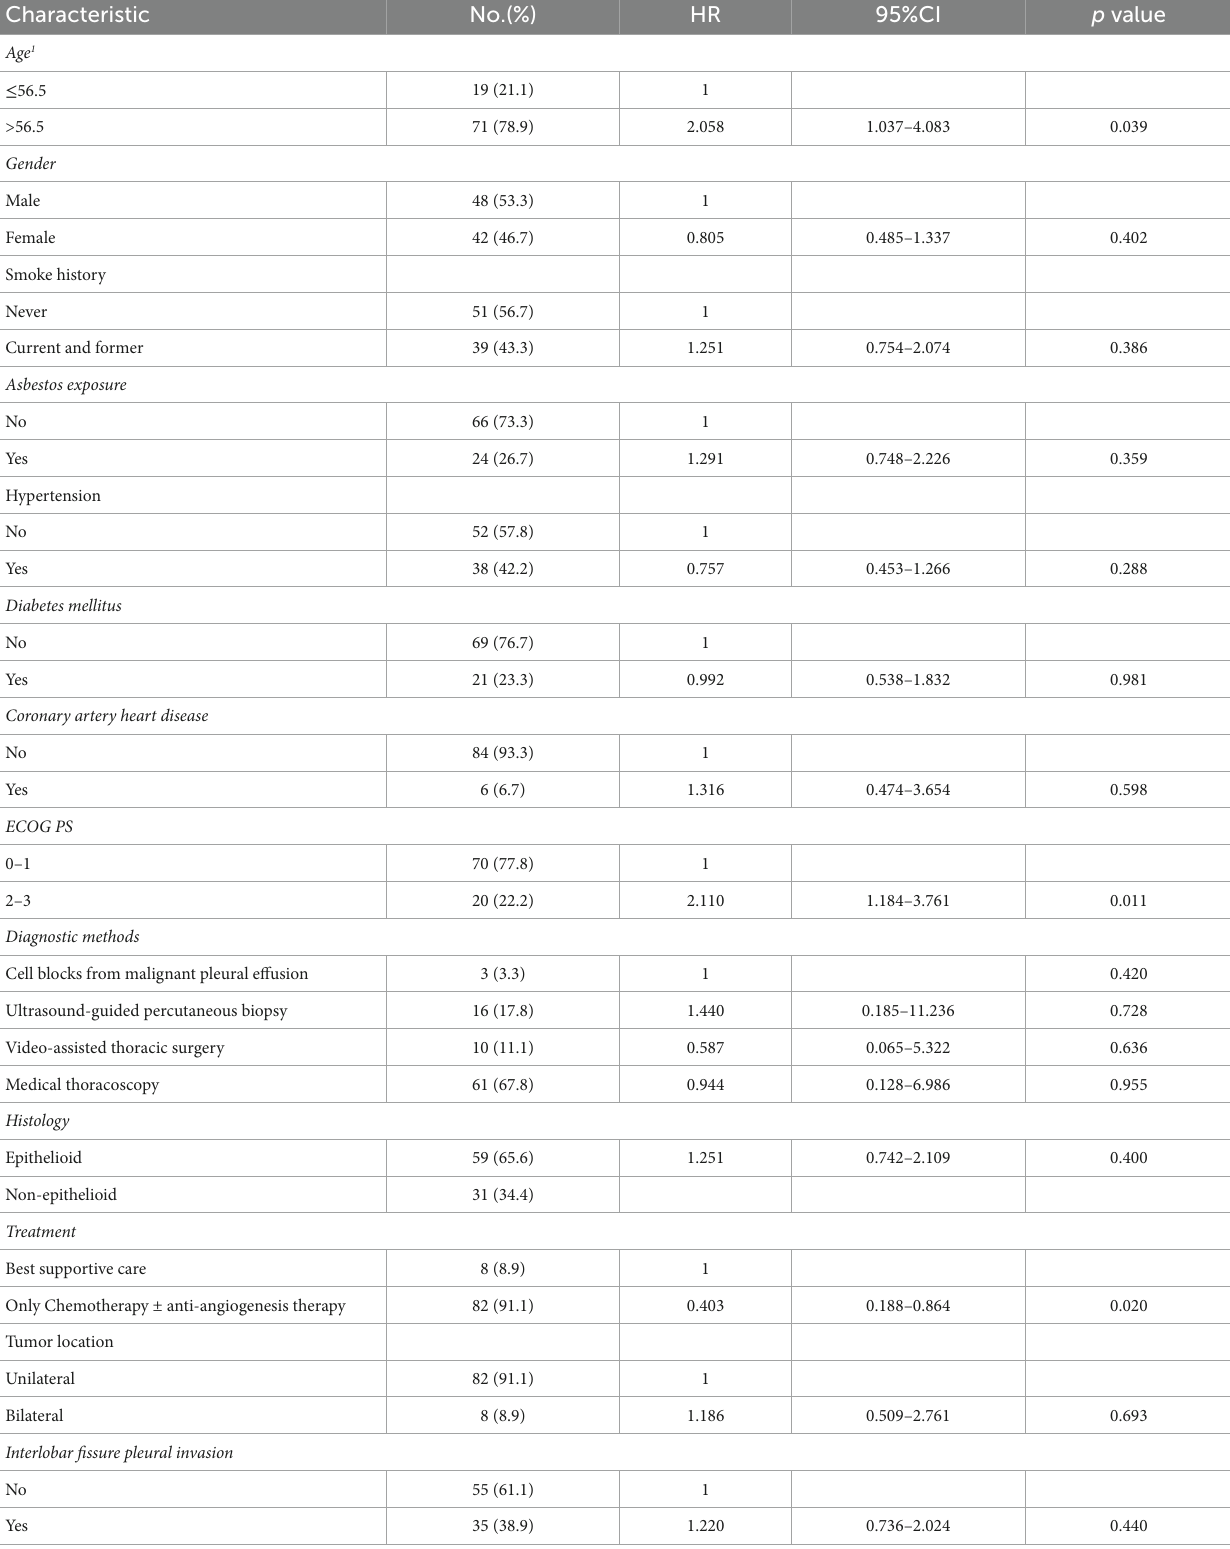
TABLE 2 Univariable Cox regression analyses between baseline characteristics, laboratory variables, and OS of malignant pleural mesothelioma patients. Characteristic No.(%) HR